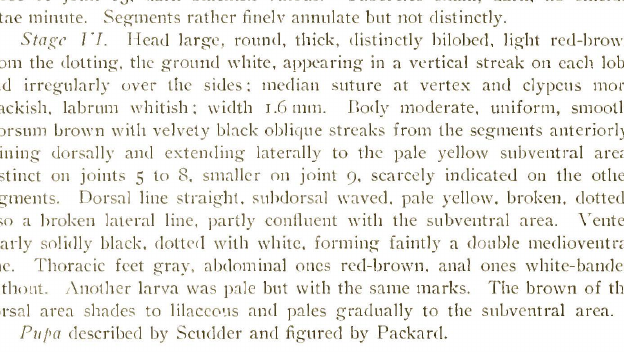
Stage T ·. Head moderately bilobecl, erect. broad; ground white checkered with reel brown in alternating oblique bars, leaving a white streak over the vertex of each lobe and eye, in clypens and over labrum; a black shade before ocelli; width 1.1 mm. Dody broadly clark brown dorsally, shaeling to olivaceous at the sides, including a narrow pulverulent dorsal and subdorsal line. the latter waveel; subventral fold broadly pnle yellow. \'enter and feet, except those of joint r3. clark blackish vinous. Tubercles small, dark, no shields, setae minute. Segments rather finelv annulate but not distinctly. Stap:c T ·1. Head large, round, thick, distinctly hi lobed, light reel-brown irom the dotting. the grounel white, appearing in a vertical streak on each lob<.! and irregularly over the sieles; median suture at vertex anel clypeus more blackish, labrum whitish; width r .6 mm. Dody moderate, uniform, smooth. Dorsum urown with velvety black oblique streaks from the segments anteriorly. JOining elorsally and extending laterally to the pale yellow subventral area, distinct on joints 5 to 8. smaller on joint 9. scarcely indicateel on the other segments. Dorsal line straight. subdorsal waved. pale yellow. broken, clotted: also a broken lateral line, partly conHuent with the subventral area. \ 'enter nearly solidly black, dotted with white, forming faintly a donble meclioventral line. Thoracic feet gray, abdominal ones reel-brown. anal ones white-banded withollt. Another larva was pale but with the same marks. The brown of the dorsal area shades to lilacco~1s and pales gradually to the suLventral area. Puj•a described by Scudder and figured by